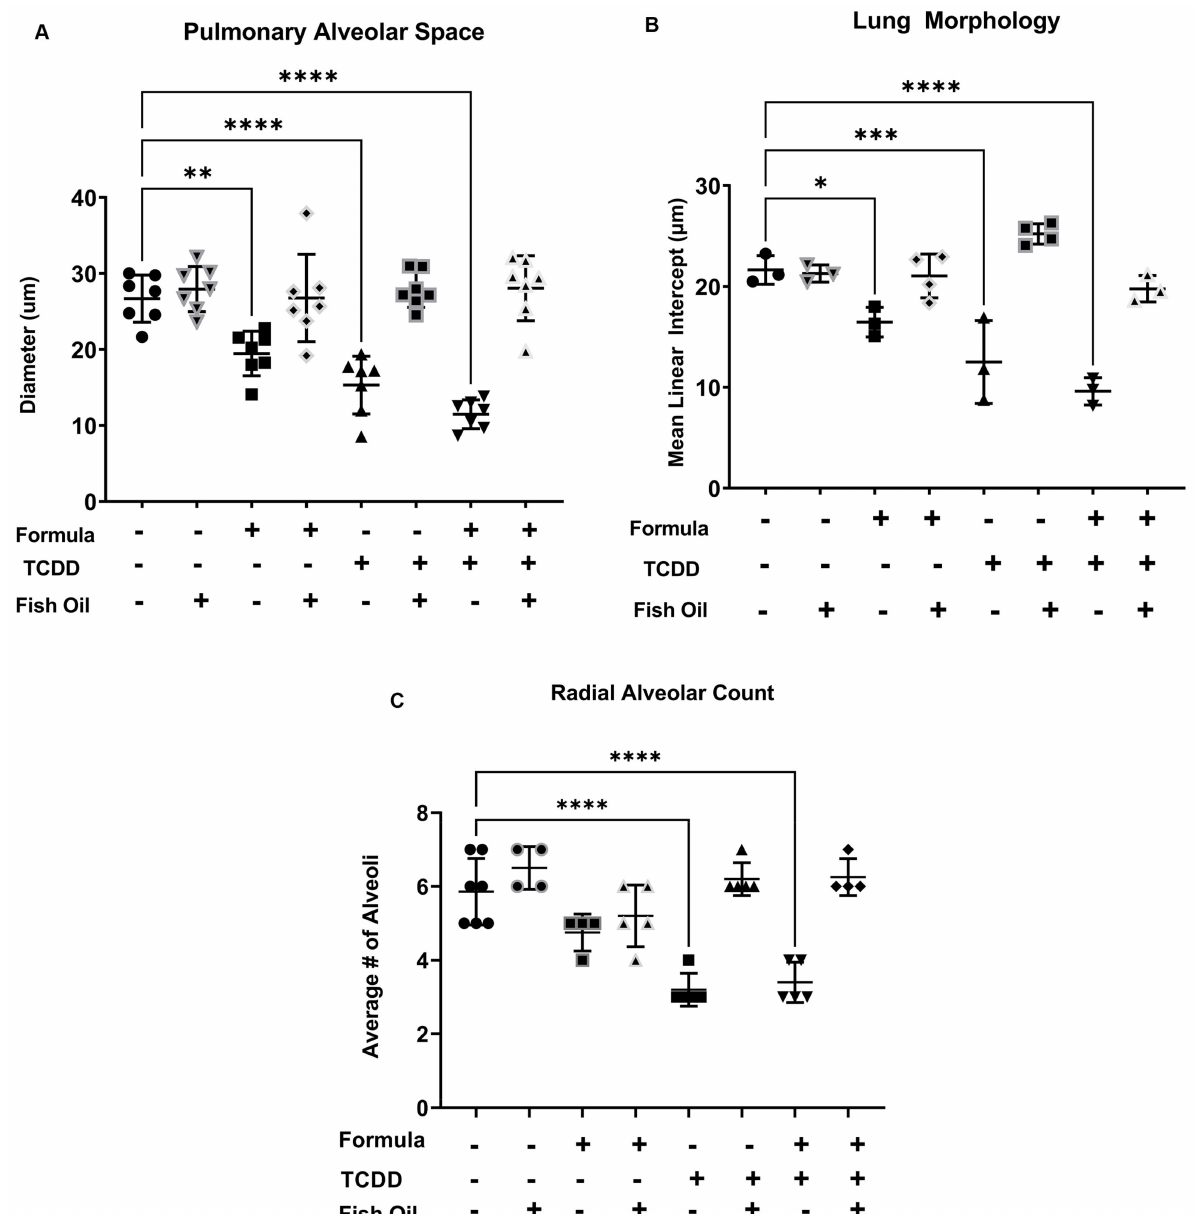
Figure 3. A paternal dietary fish oil intervention improves the alveolarization of pup lungs: Pul- monary alveolar space ( A ), mean linear intercept ( B ), and radial alveolar count ( C ) of CT and F2TCDD pups ± a fish oil intervention and/or supplemental formula was measured on PND11. Groups used for manual determination of pulmonary alveolar space and radial alveolar count contained 6–10 non-littermates. Data points represent the mean values from individual pups. Standard deviation is shown. Groups used for automated mean linear intercept contained 3–4 non-littermates.* p ≤ 0.05; ** p ≤ 0.01;*** p ≤ 0.001;**** p ≤